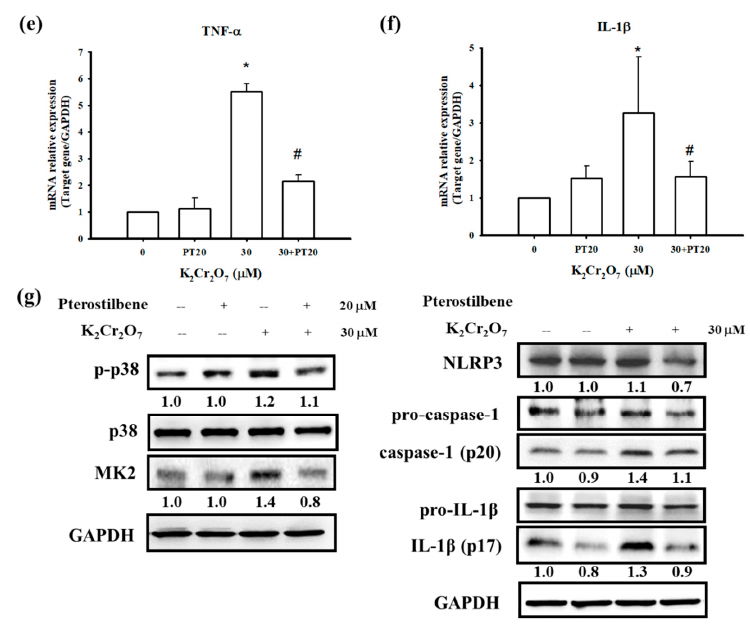
Figure 7. PT attenuates the Cr(VI)-induced pro-inflammatory cytokines and NLRP3 inflammasome. ( a , b ) The mRNA expressions of TNF- α and IL-1 β were measured by real-time PCR. HaCaT cells were treated with several concentrations (7.5, 15, 30, and 45 μ M) of Cr(VI) for 12 h. Data presented as the mean ± SD from three independent experiments. * p <0.05 versus controls. ( c , d ) The expression of the p38 MAPK/MK2 signaling pathway and NLRP3 inflammasome-associated proteins were measured by Western blot analysis following treatment with several concentrations of Cr(VI) for 24 h. ( e , f ) The cells were pretreated with PT (20 μ M) for 1 h and then treated with Cr(VI) (30 μ M) for an additional 12 h. Real-time PCR showed that the mRNA levels of pro-inflammatory cytokines, TNF- α and IL-1 β decreased after treatment with PT. ( g ) Western blot analysis demonstrated that the activation of the p38 MAPK/MK2 signaling pathway and the NLRP3 inflammasome was suppressed by PT. Western blots are representative of n = 3 experiments.